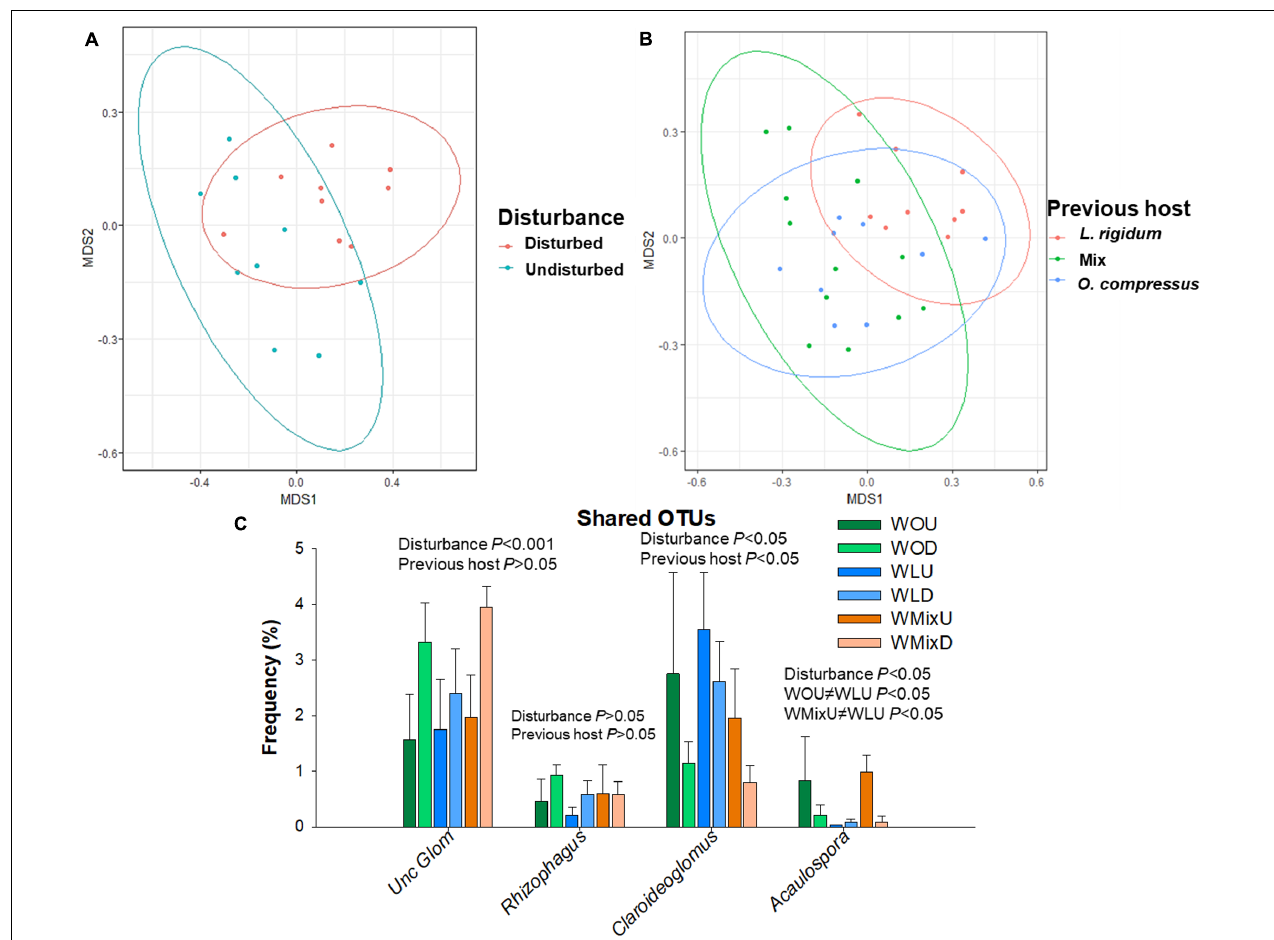
FIGURE 3 | Effects of extraradical mycelium (ERM) disturbance and previous host on AMF communities’ composition in wheat ( Triticum aestivum ). (A) Effect of extra-radicular mycelia (ERM) network disruption on wheat AMF composition represented in multidimensional space (NMDS plot) considering the communities associated to wheat from the undisturbed and disturbed treatments. Ellipses represent ordination confidence intervals (95%), stress = 0.12. (B) NMDS plot of OTU composition in wheat + O. compressus + L. rigidum on standardized data, showing that they form groups according to first host: L. rigidum , O. compressus or a mixture of both species. Ellipses represent ordination confidence intervals (95%), stress = 0.20. (C) Frequencies of shared AMF taxa grouped by genera in wheat. OTUs with no match in the databases at genus level were considered as uncultured Glomeraceae. Significant differences between treatments were assessed by Two-way ANOVA, with disturbance and first hosts as factors. WOU (wheat after O. compressus , undisturbed soil), WOD (wheat after O. compressus , disturbed soil), WLU (wheat after L. rigidum , undisturbed soil), WLD (wheat after L. rigidum , soil disturbed), WMixU (wheat after O. compressus + L. rigidum , undisturbed soil), WMixD (wheat after O. compressus + L. rigidum , disturbed